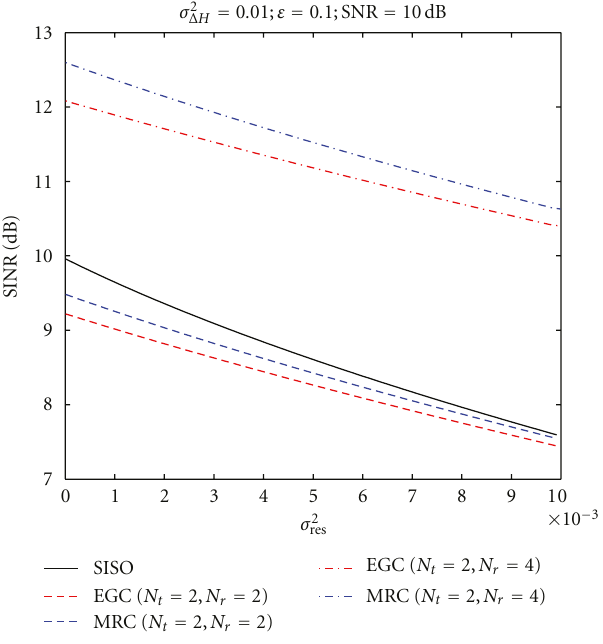
Figure 4: BER with QPSK when ( N t = 1, N r = 1).